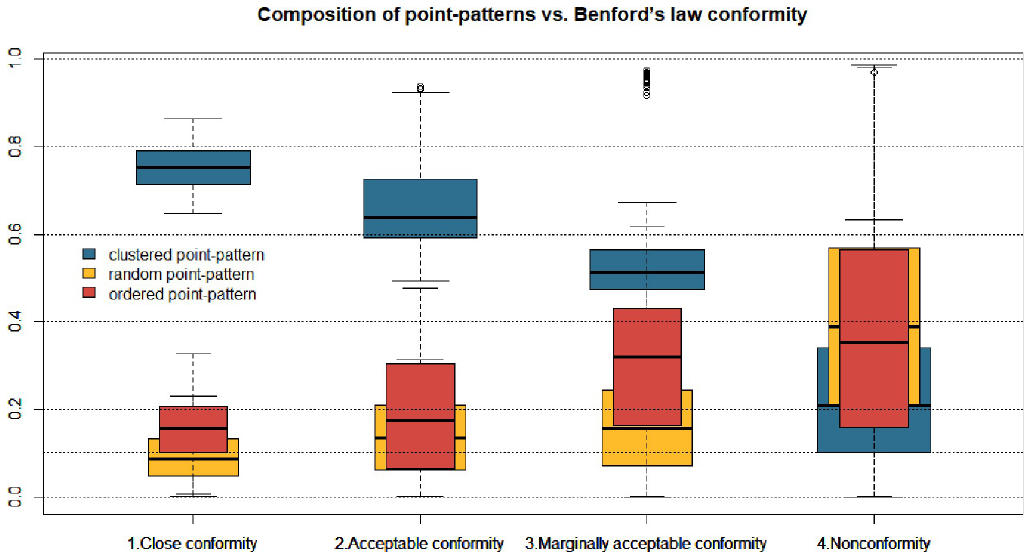
Fig 9. Simulated mixture of point patterns to test Benford. Source: Own study with the use of R software.